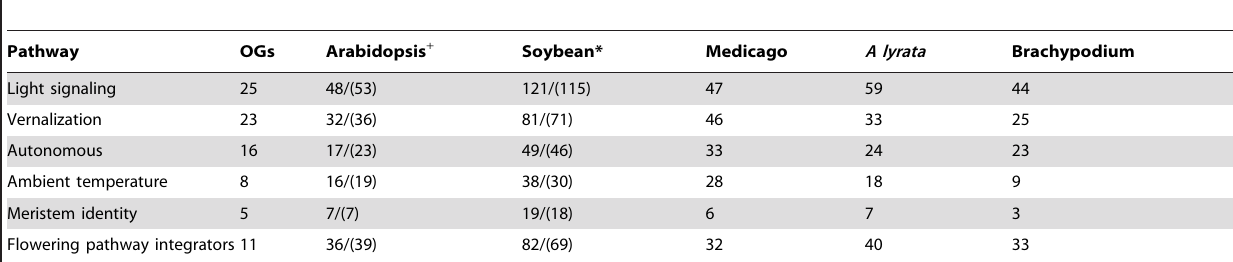
Table 1. Key flowering pathways and the numbers of associated genes in Arabidopsis, soybean, Medicago, A. lyrata and